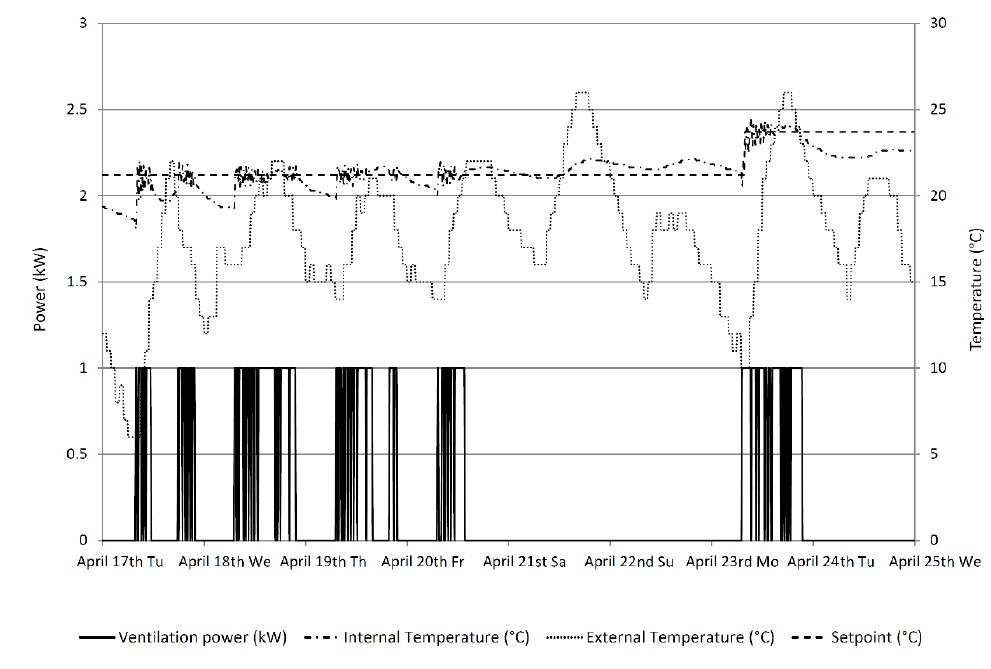
Figure 8. CL-3-Classroom 1.4 AHU ventilation operation with the EEM.